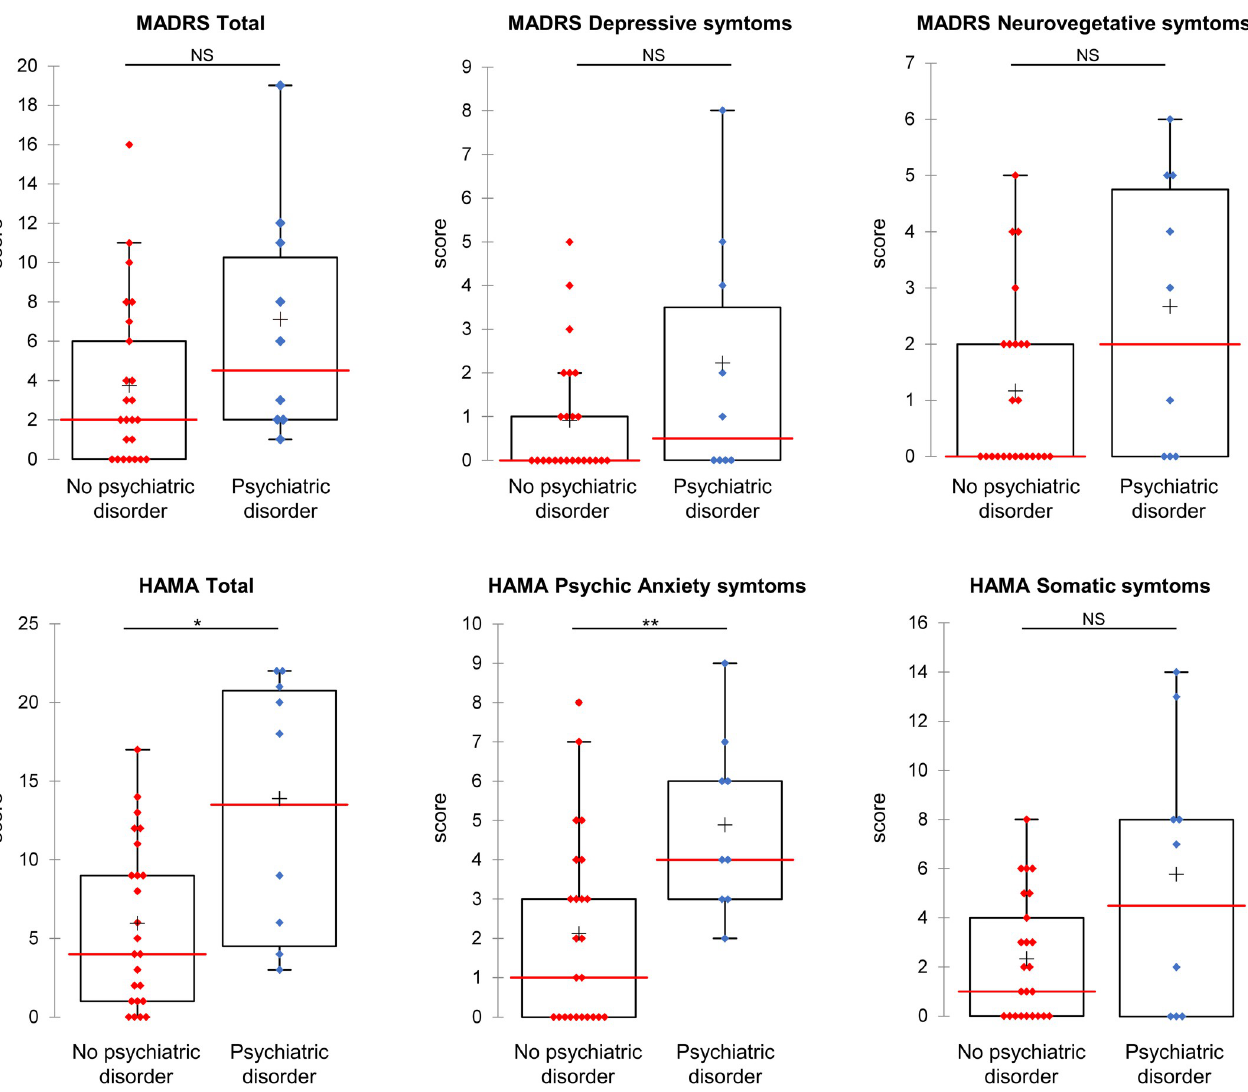
Fig 3. Comparison of baseline MADRS, HAMA and symptom scores in patients according to the occurrence or not of a psychiatric disorder. Patients who developed a psychiatric disorder are presented in blue (labelled psychiatric disorder), patients who never developed a psychiatric disorder during the follow-up are presented in red (labelled no psychiatric disorder). Baseline scores are presented as Box plot with interquartile range and 95% confidence interval. Median and mean scores are presented as red line and black cross respectively. Significant different: � p < 0.05 and �� p <